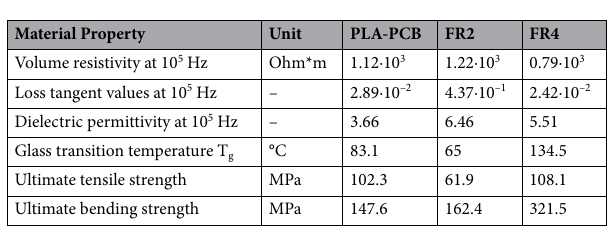
Figure 2. Permittivity measurement results of three PCB plates: ( a ) volume electrical resistivity, ( b ) the loss tangent values, ( c ) dielectric permittivity, ( d ) thermogravimetric-differential scanning calorimetry, ( e ) ultimate tensile strength, and ( f ) flexural test.